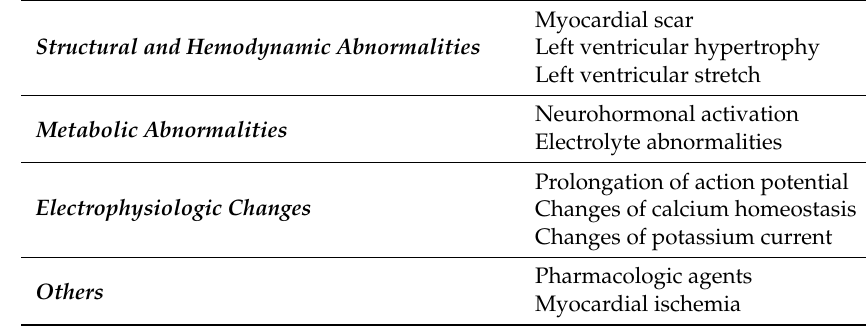
Table 1. Factors involved in pathogenesis of tachyarrhythmias in patient with heart